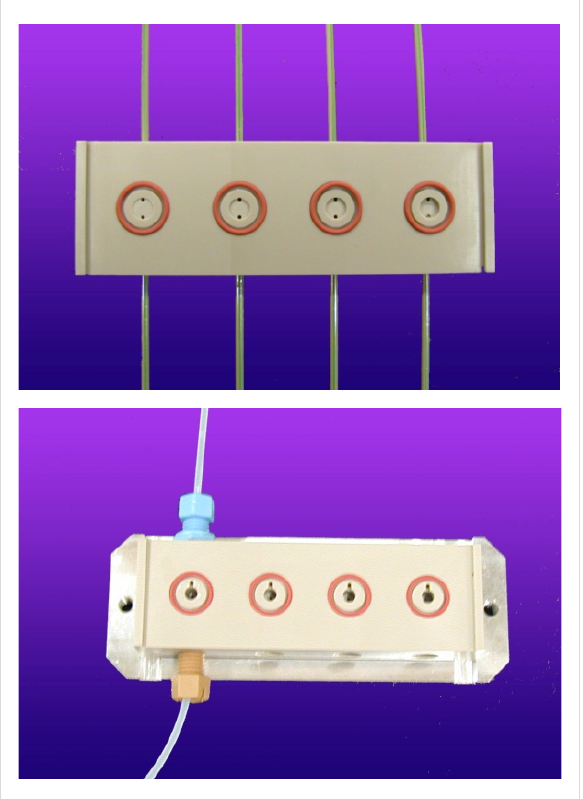
Figure 1: Four-fold PEEK-reactors with increasing chamber depths from left to right and different techniques of fluid connection; top: glued PEEK-capillaries, bottom: ¼ in. screw